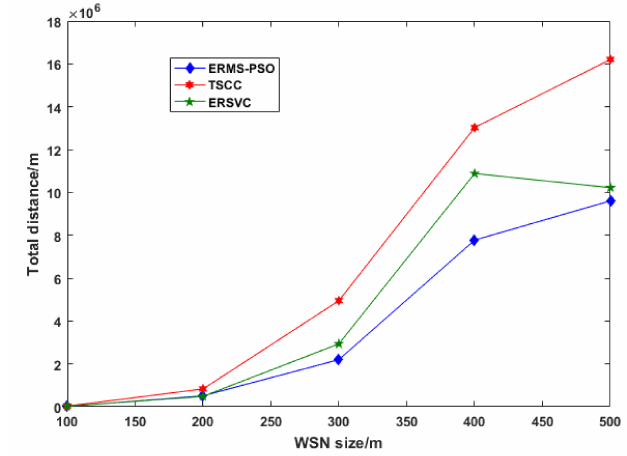
Figure 6. WMCD travel distance.